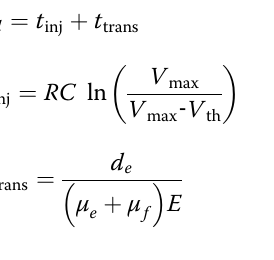
Fig. 2 a Test circuit of transient voltage discharge characteristics measurement. b Time-resolved transient voltage decay characteristics at 5 V ( D 1 , D D τ ≈ 100 μ s. The orange dashed arrow shows different fall rates of devices]. c Turn-on voltage ( V 2 , and 3 ). [Inset: A fast decay time 1 and S 3 [Inset: Luminance – voltage curves]. d Normalized time-resolved electroluminescence (EL) intensity of S 1 , S 2 , and S 3 at 9 V. (The orange dashed line show the EL onset time of devices which is about 0.32 μ s, 1.05 μ s, and 0.48 μ s,